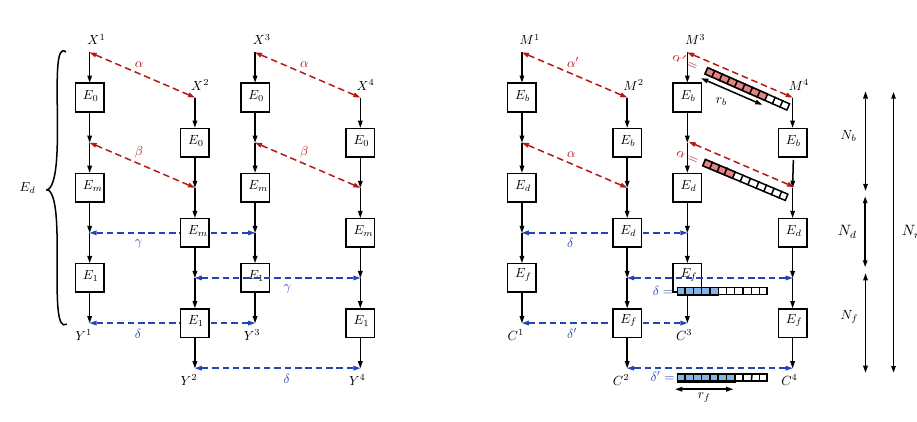
Figure 3: Sandwich distinguisher (left) and setting for an attack, including the key recovery